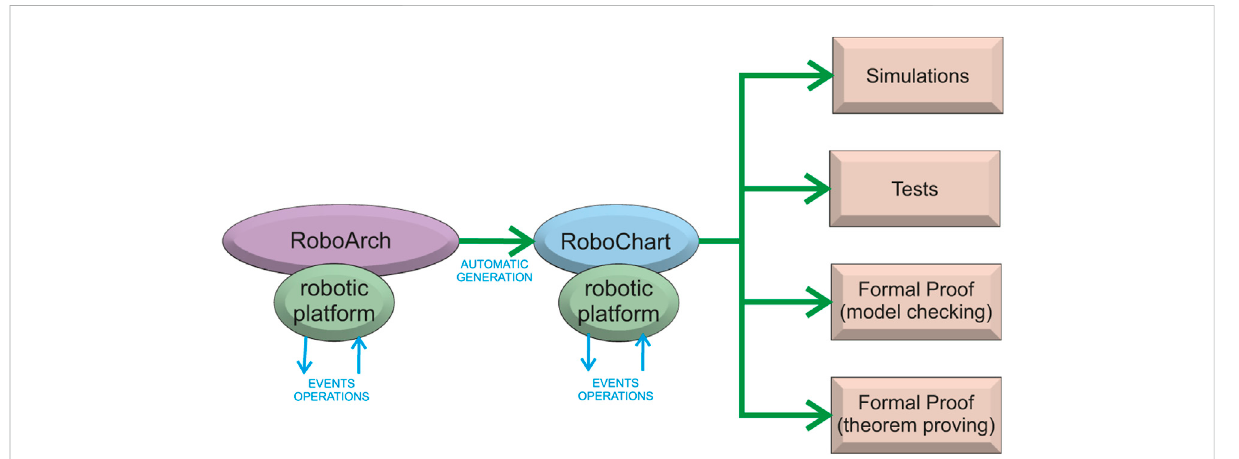
FIGURE 1 RoboArch in the context of RoboStar. With a RoboArch architectural design, we can generate automatically a sketch of a RoboChart behavioural model. Using the RoboChart model, we can take advantage of a plethora of modern veri fi cation techniques supported by automated generation of